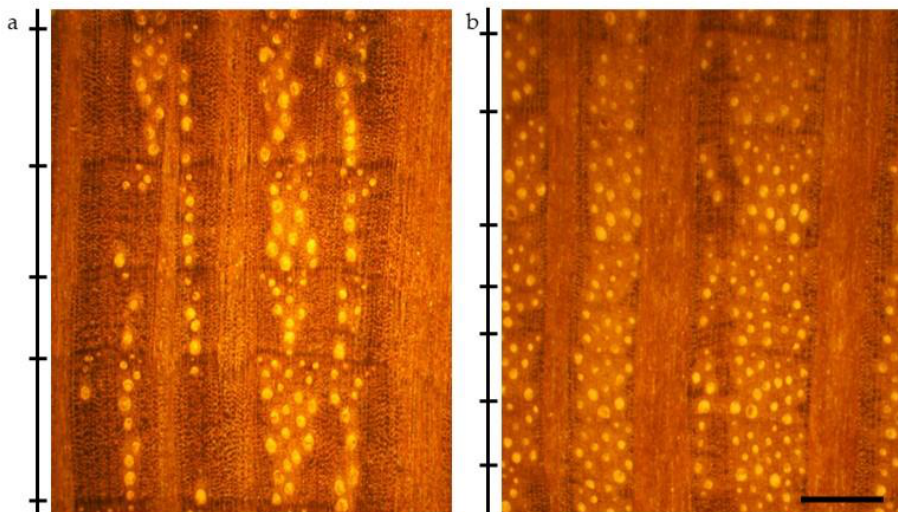
Figure 1. Growth ring boundaries of the studied Quercus rotundifolia Lam. trees shown in a transverse section: ( a ) distinctly marked by the occurrence of fibre tissue without pores and rings showing a gradual pore size variation; ( b ) less distinct and narrower rings resembling diffuse porosity due to a more gradual pore size variation. Ring boundaries are represented by ticks at the left of each image. Scale bar = 1 mm.